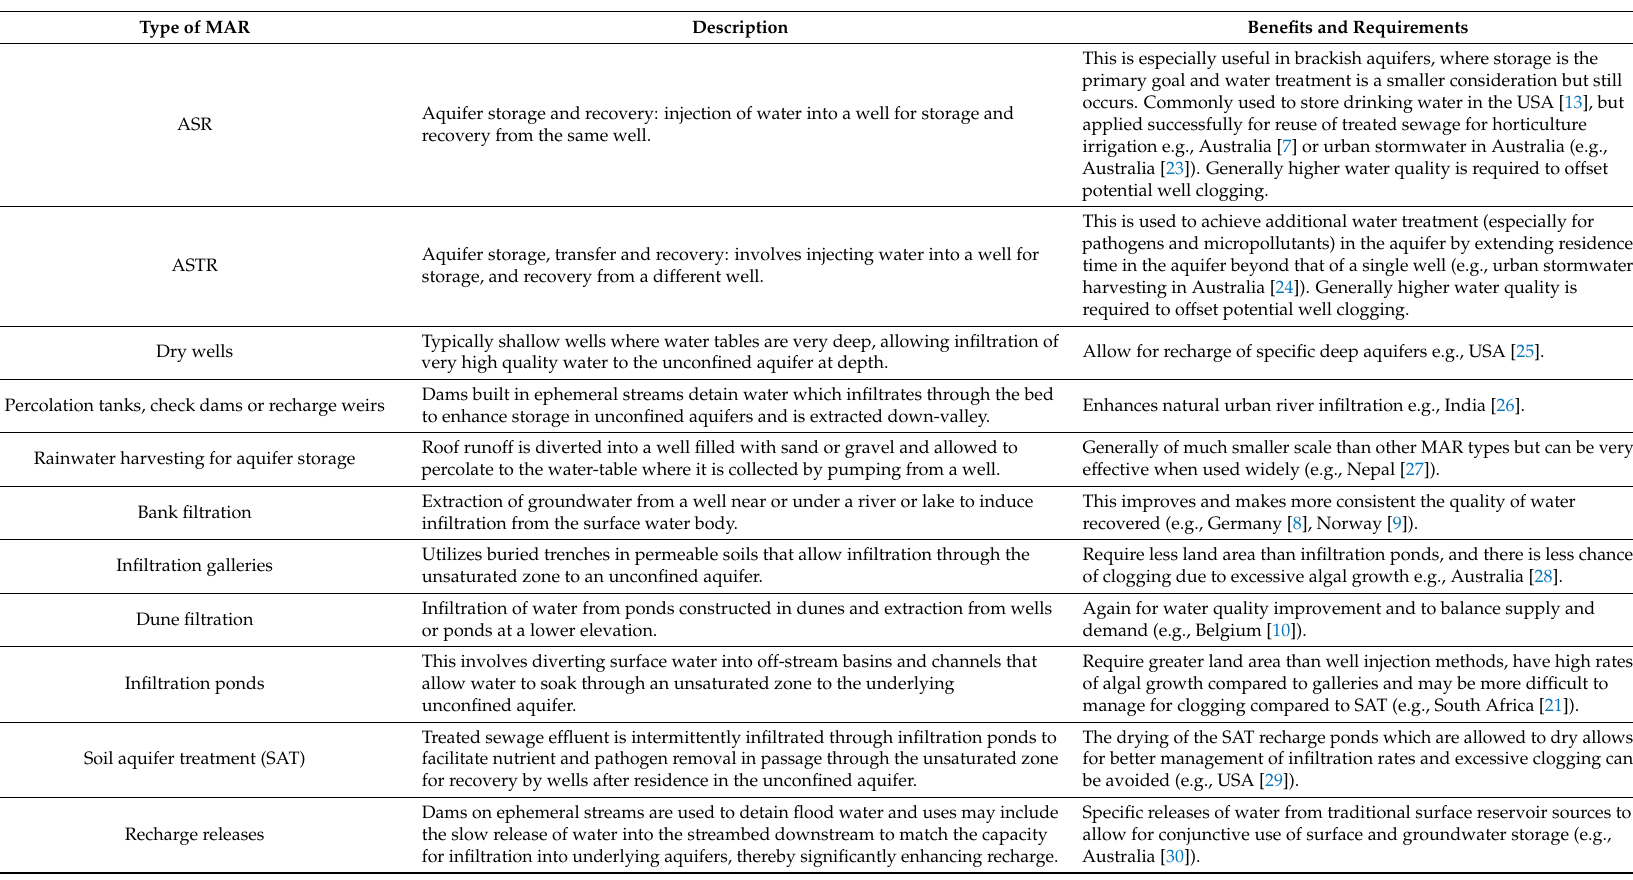
Table 1. Examples of types of MAR in urban settings (modified from Dillon 2005